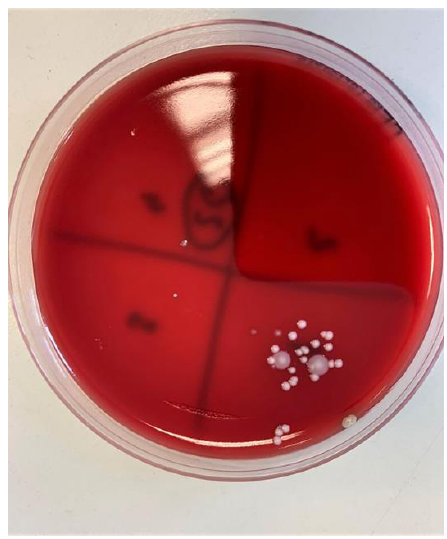
Figure 11. Blood agar plate ready for CFU/mL analysis.